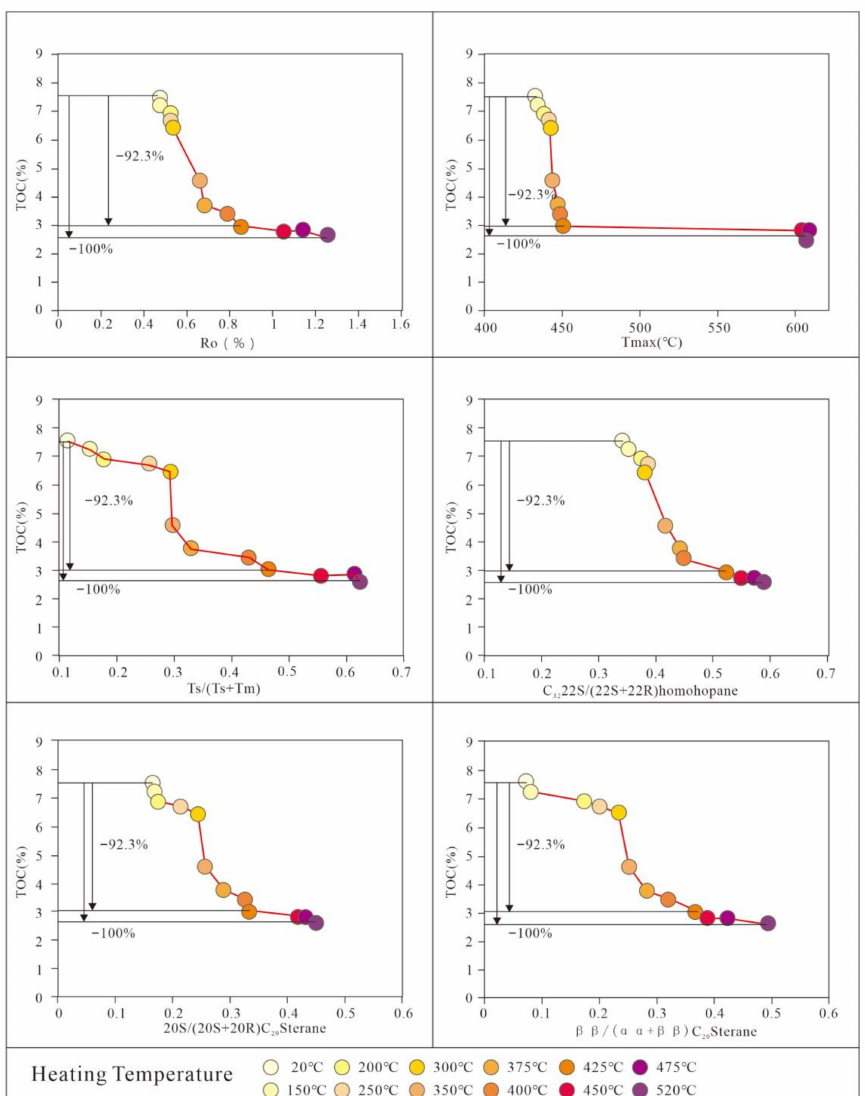
Figure 10. The changes in the six maturities and TOC contents of Nongan samples at different pyrolysis